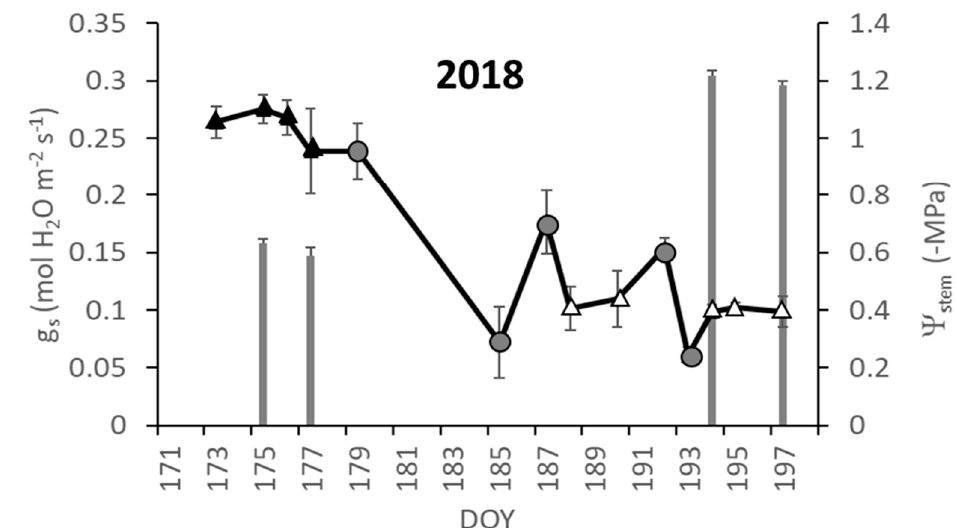
Figure 1. Plant water status during the 2017 and 2018 assays (all genotypes together). Lines and symbols represent the g s (left axis) and bars represent Ψ stem (right axis). Values are the mean of all measurements of the 23 genotypes per day and errors bars represent the standard error (n = 25–50). Black triangles represent a measure of well-watered (WW) status, white triangles a measure of moderate water stress (MWS), and grey circles a control of the plant water status.